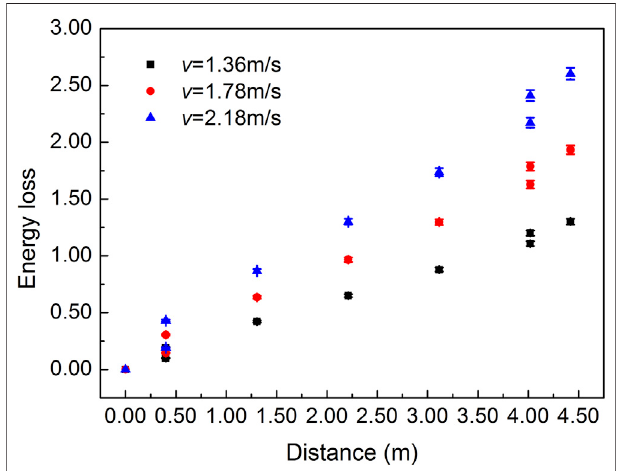
FIGURE 3 | Effects of fl uid velocity on the heat